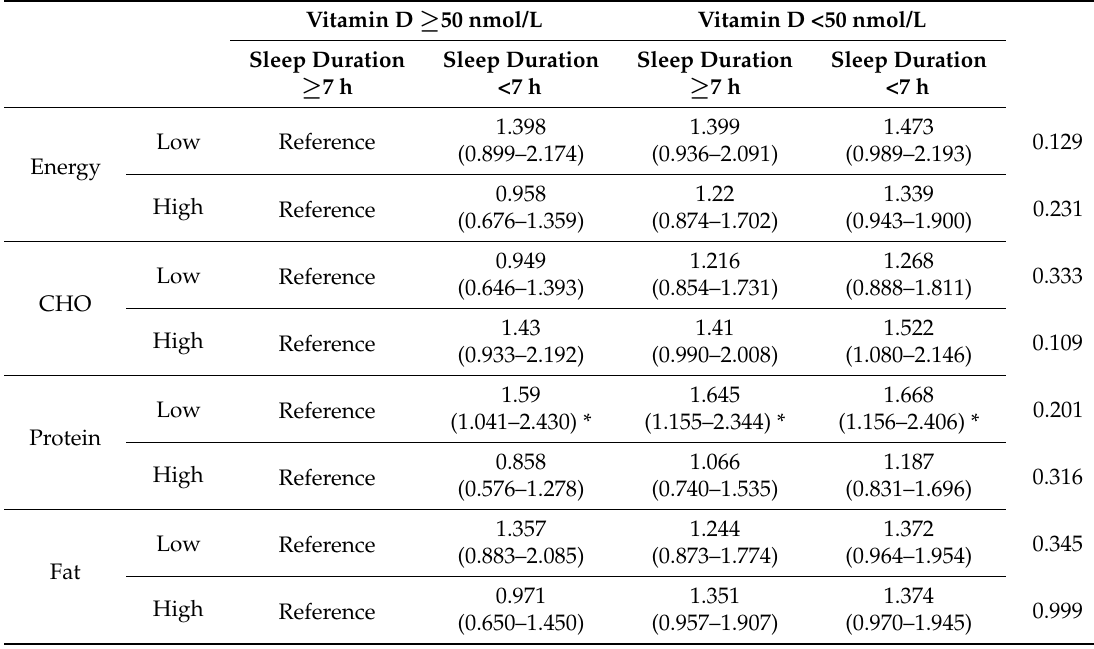
Table 4. Association between the 25-hydroxyvitamin D concentration and sleep duration with obesity according to dietary macronutrient